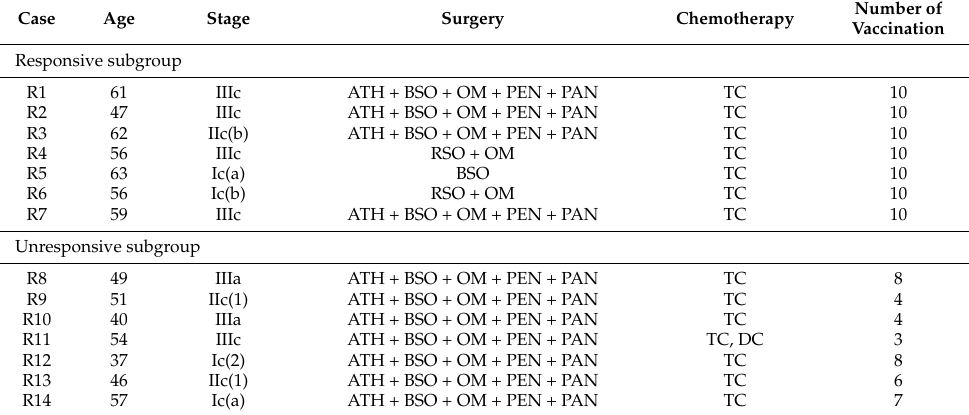
Table 1. Characteristics of patients in remission.